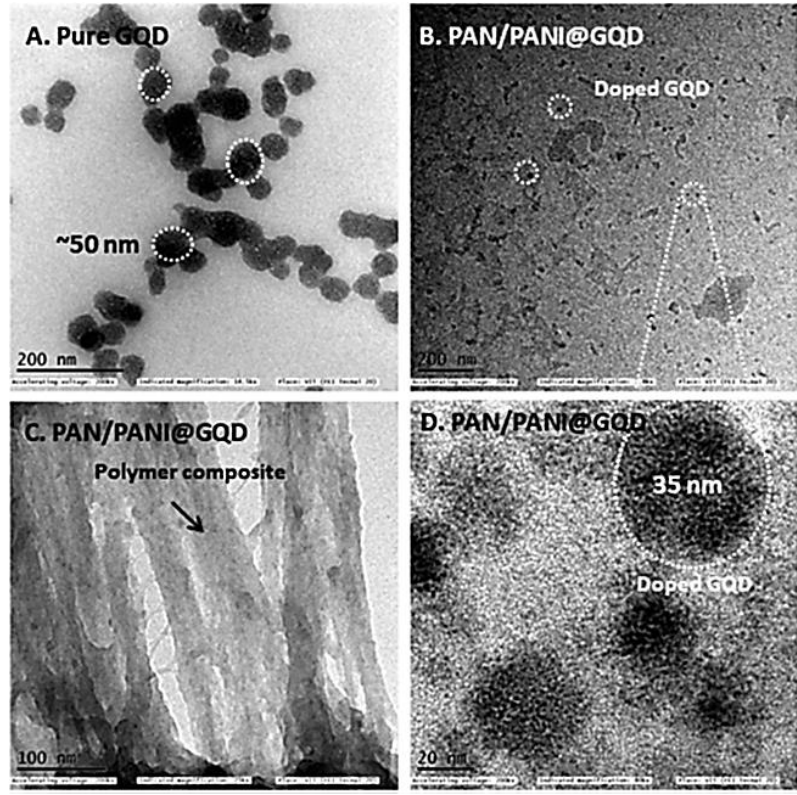
Figure 4. TEM images of ( A ) Pure GQD; ( B – D ) PAN/PANI@G − 1.5 wt.% nanocomposite at different magnifications [85]. PAN/PANI@G = polyaniline/polyaniline/graphene quantum dot; GQD = graphene quantum dot. Reproduced with permission from Elsevier.